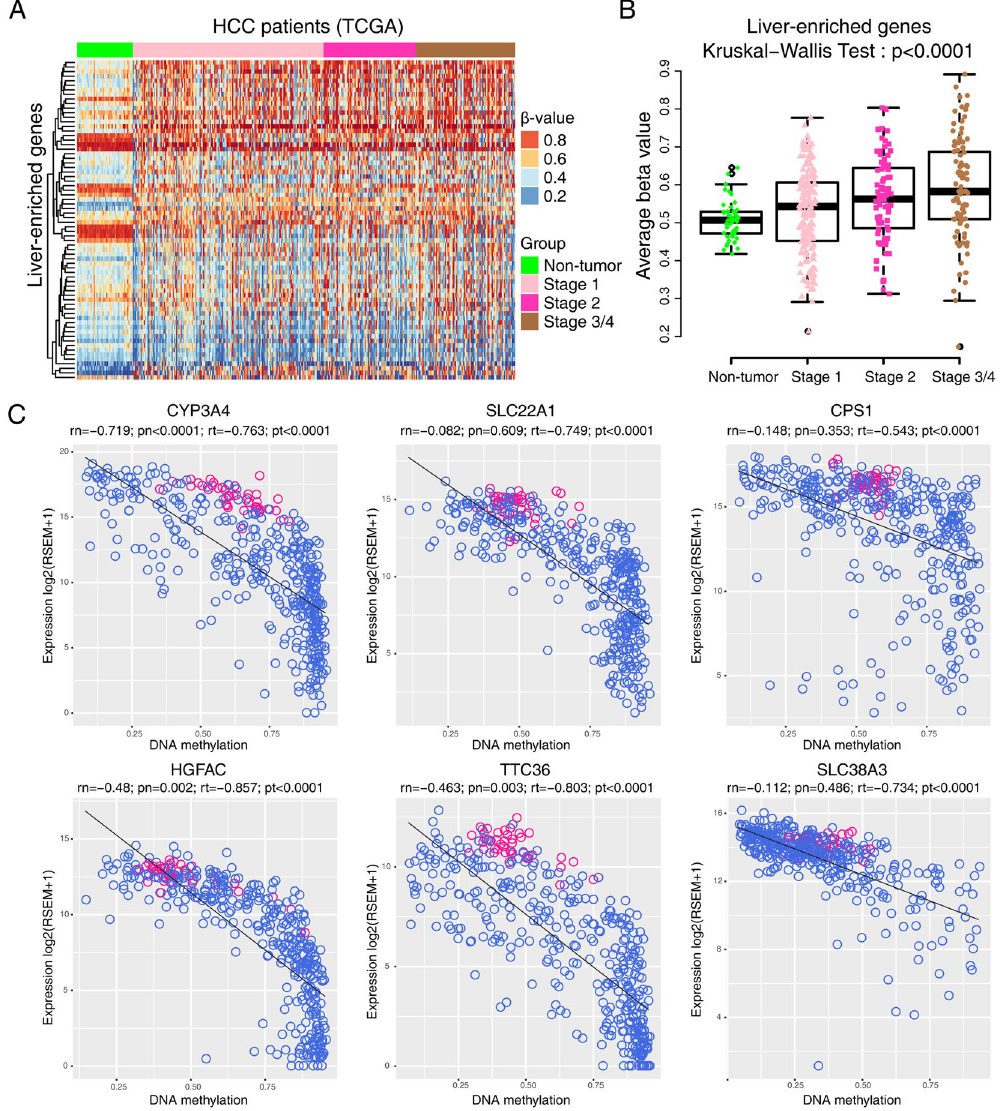
Figure 5. Methylation patterns of liver-enriched genes. ( A ) Heatmap showing the methylation patterns of liver-enriched genes in non-tumor tissues and HCC of different pathological stages. The beta values were used to draw the heatmap. ( B ) Average methylation levels of liver-enriched genes in non-tumor and tumor tissues. ( C ) Scatterplots of representative liver-enriched genes shown to be hypermethylated in HCC, where gene RNA expression (y axis) is plotted against relative hypermethylation (x axis). Blue dots are results from tumor samples, and pink dots are results from normal tissues. Abbreviations in figures: rn, Spearman r value of non- tumor tissue; pn, p-value of non-tumor tissue; rt, Spearman r value of tumor tissue; pt, p-value of tumor